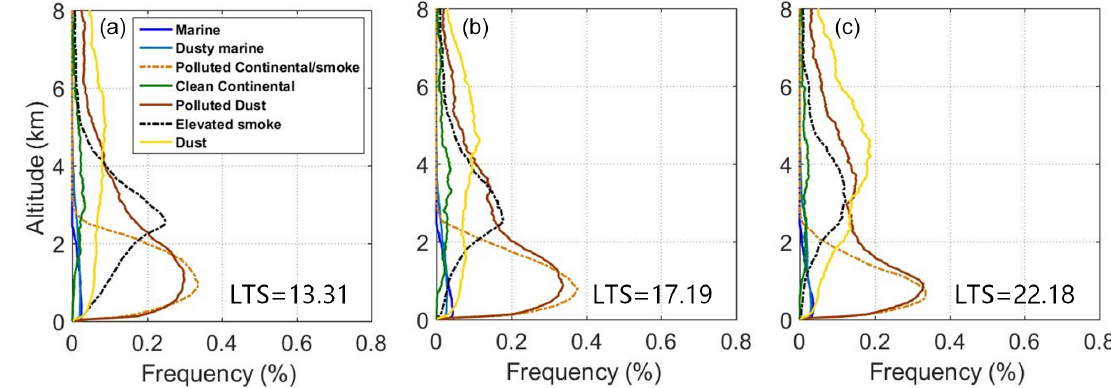
Figure 9. Vertical distributions of the nighttime FOs of different aerosol types (see legend) for data stratified by unstable atmosphere (a) , neutral stable atmosphere (b) and stable atmosphere (c) over the YRD, averaged over the years